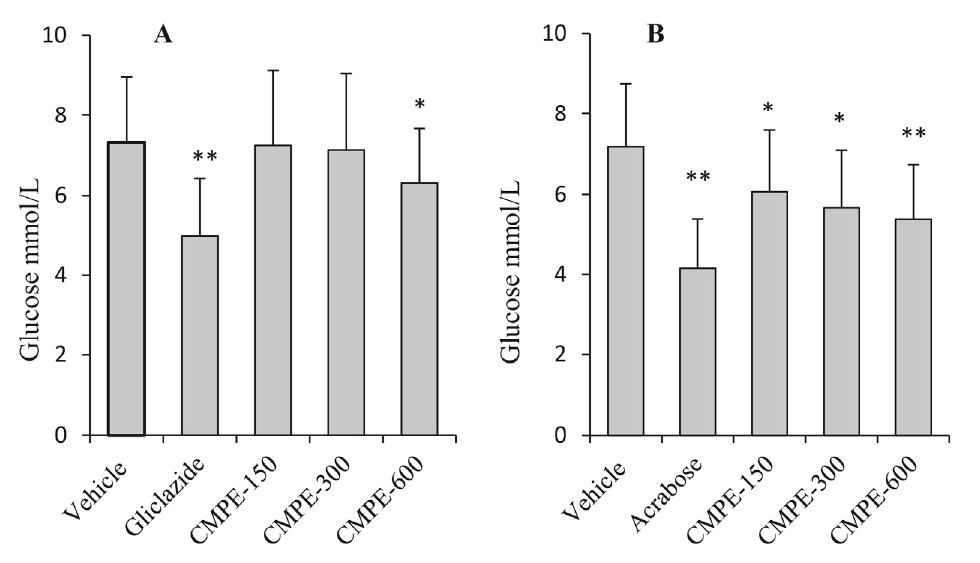
Figure 7. The inhibition of postprandial glycemic response by CMPE in normal rats after glucose ( A ) and sucrose ( B ) challenge ( n = 5). The fasted rats were orally administrated with vehicle solutions, 100 mg/kg gliclazide, 20 mg/kg acarbose or 150 (CMPE-150), 300